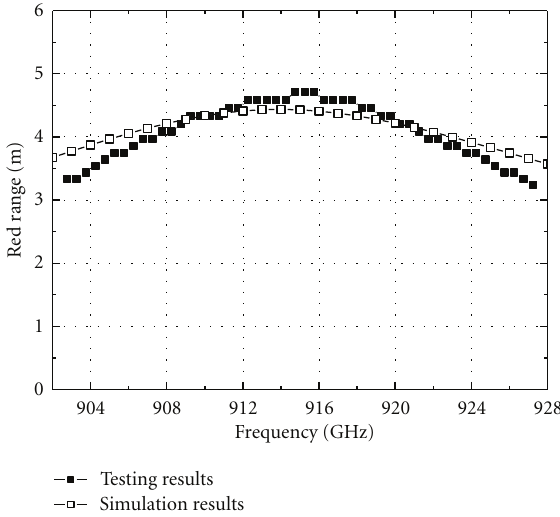
Figure 8: Theoretical and experimental read ranges for the open stub feed patch antenna ( EIRP = 4 W).